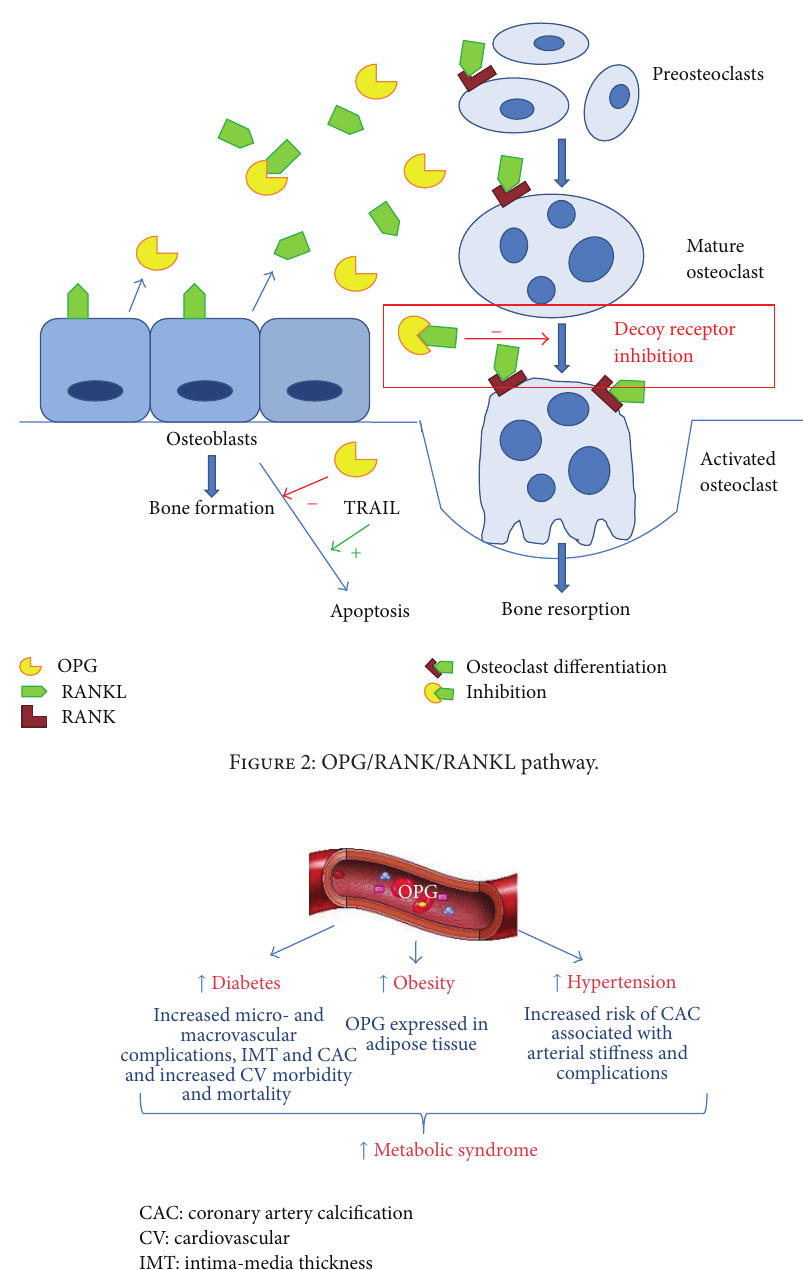
Figure 3: Summary of osteoprotegerin involvement in different endocrinological pathologies including diabetes, hypertension, obesity, and metabolic